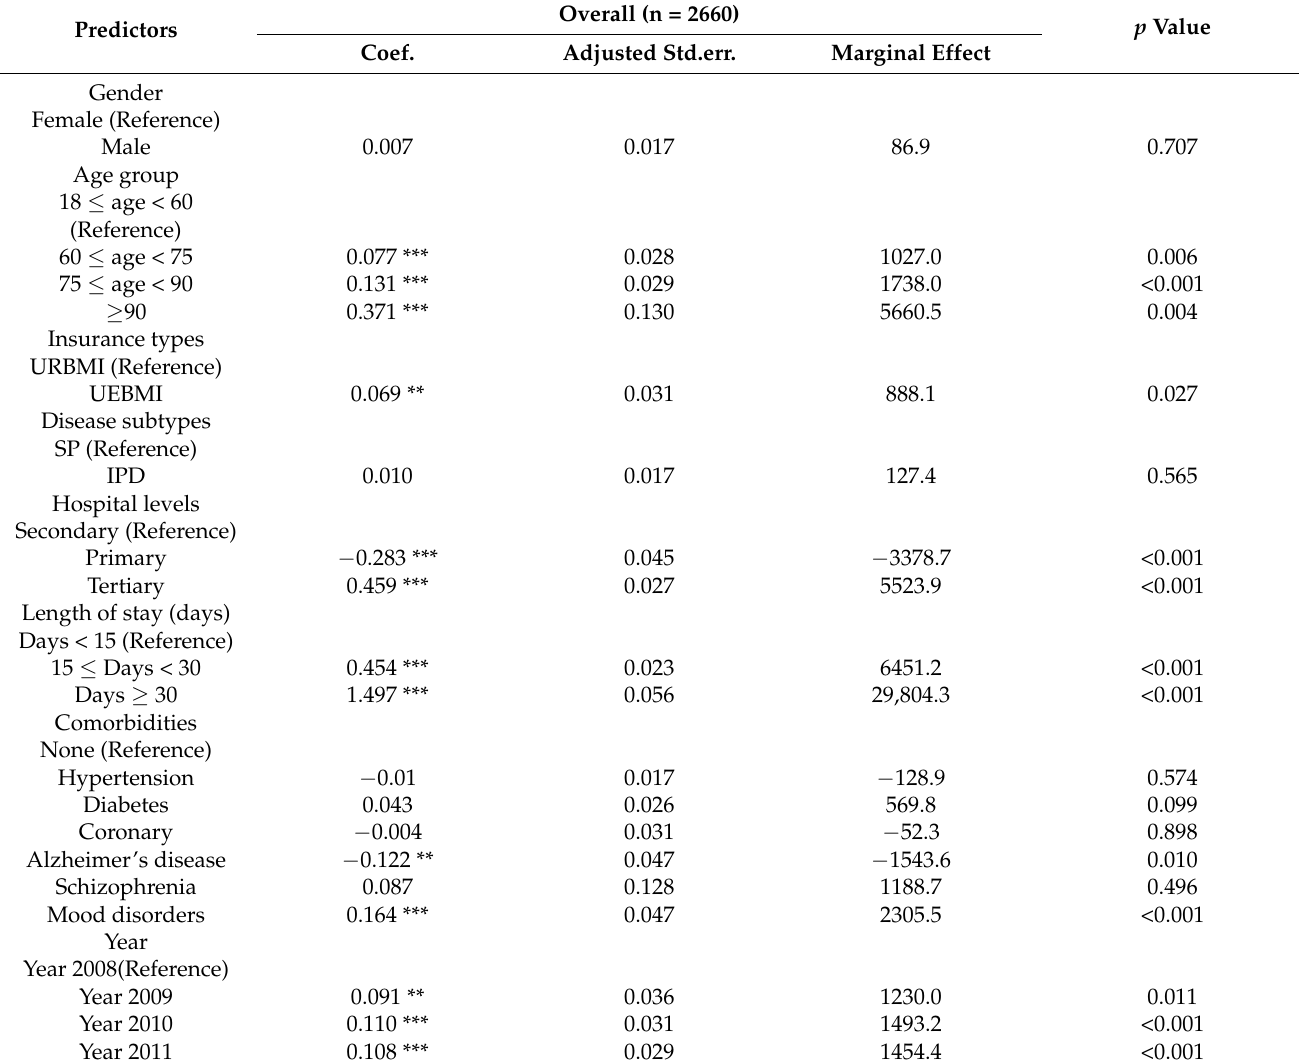
Table 7. Factors associated with direct inpatient costs (EEE